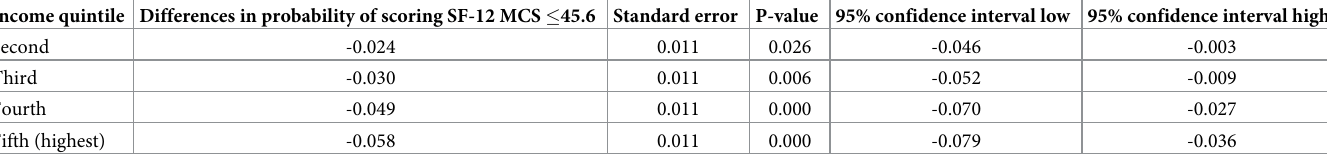
Table 4. Marginal Effects at the Means (MEM) by net equivalised household income